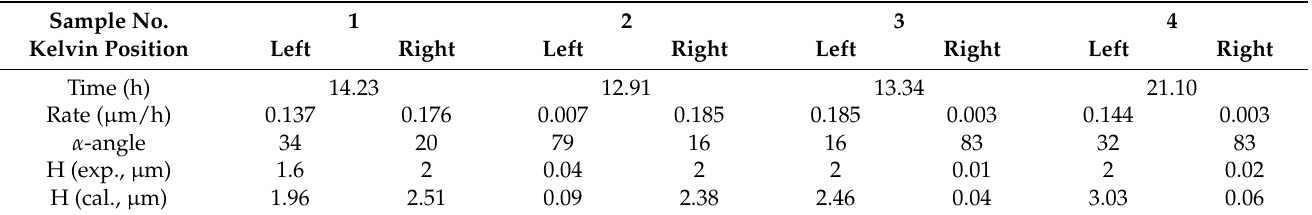
Table 1. Comparison of theoretical and experimental consumption rates of Ni UBM at high cur- rent densities.